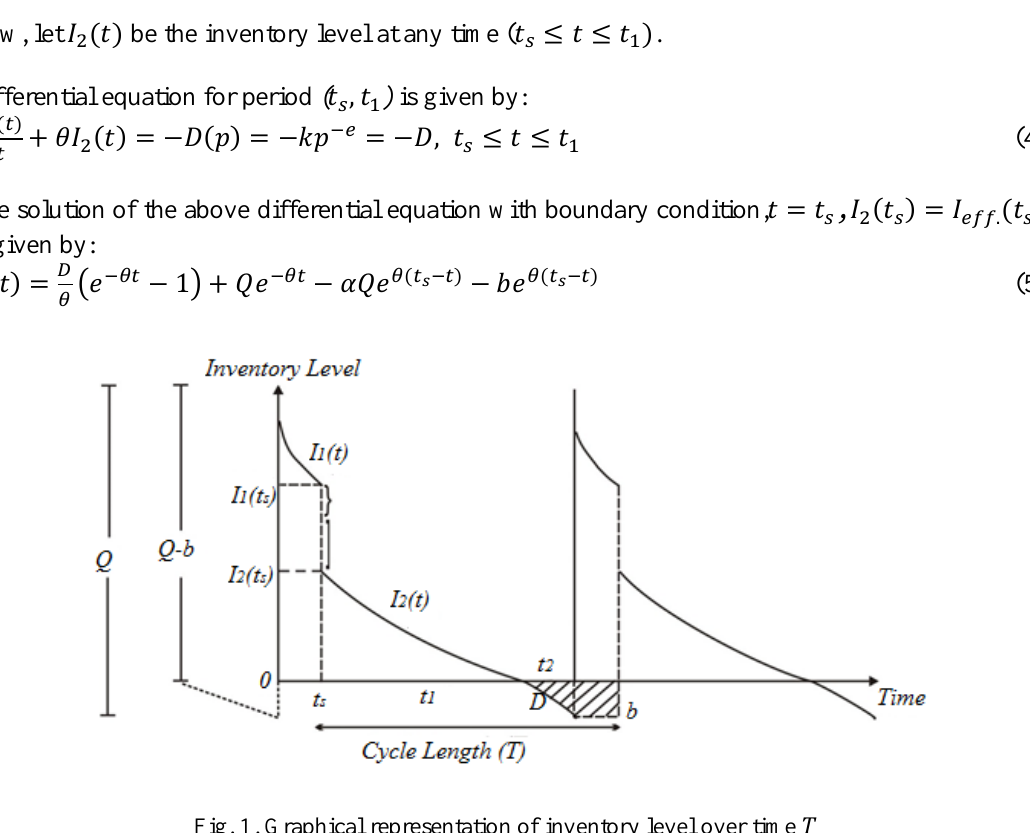
Fig. 1. Graphical representation of inventory level over time